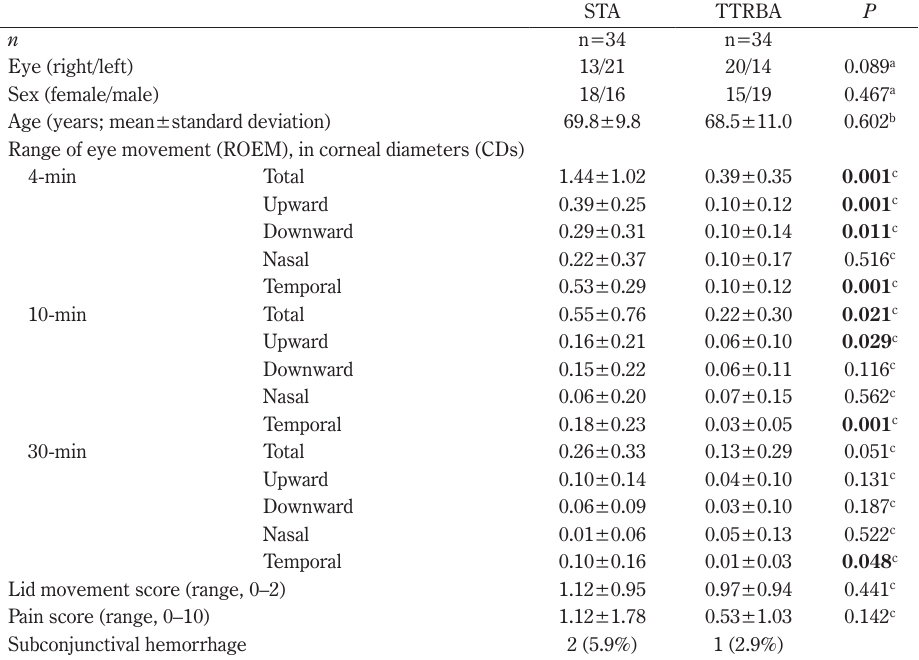
Table 1 Comparisons of results between sub-Tenon’s capsule anesthesia and trans-Tenon’s capsule retrobulbar